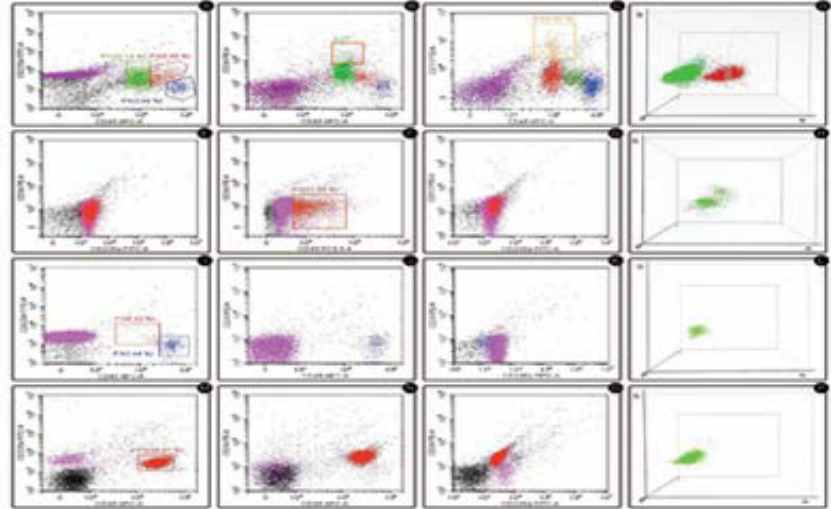
TABLE 2 - Correlation analyses of raw serum forms of the prostate-specific antigen (total and free) and their ratio across levels of the inflammatory mediators investigated in the162 older men at admission IFN γ IL1 β IL2 IL4 IL6 IL8 IL10 IL12 TNF fIGuRE 1 – Graphic representation of cell dispersion of the Dot plots type for the characterization of erythroblast populations in the bone marrow (A, B and C) by flow cytometry, where: in purple are orthochromatic erythroblasts and reticulocytes (Figure 1A to 1N); in green are polychromatic erythroblasts (Figure 1A and 1B); in red basophilic erythroblasts (Fig 1A and 1B); in orange the proerythroblasts (Figure 1C); and lymphocytes in blue (Figure 1A, 1B and 1C) in bone marrow samples. And in Figures 1E, 1F, 1G, 1I, 1J, 1K, 1M, 1N and 1O the populations of erythroblasts in peripheral blood are represented by flow cytometry, where: in purple, they are orthochromatic erythroblasts and reticulocytes; in red are polychromatic erythroblasts; and in black are likely cell debris. The complexity (FS) X nuclear fluorescence (FL) graphs are relative to the peripheral blood samples obtained in the Mindray BC6000 equipment (D, H, L and P), where: in Figure 1D the erythroblasts are represented in green and in red lymphocytes; and in Figures 1H, 1L and 1P, only erythroblasts are shown in